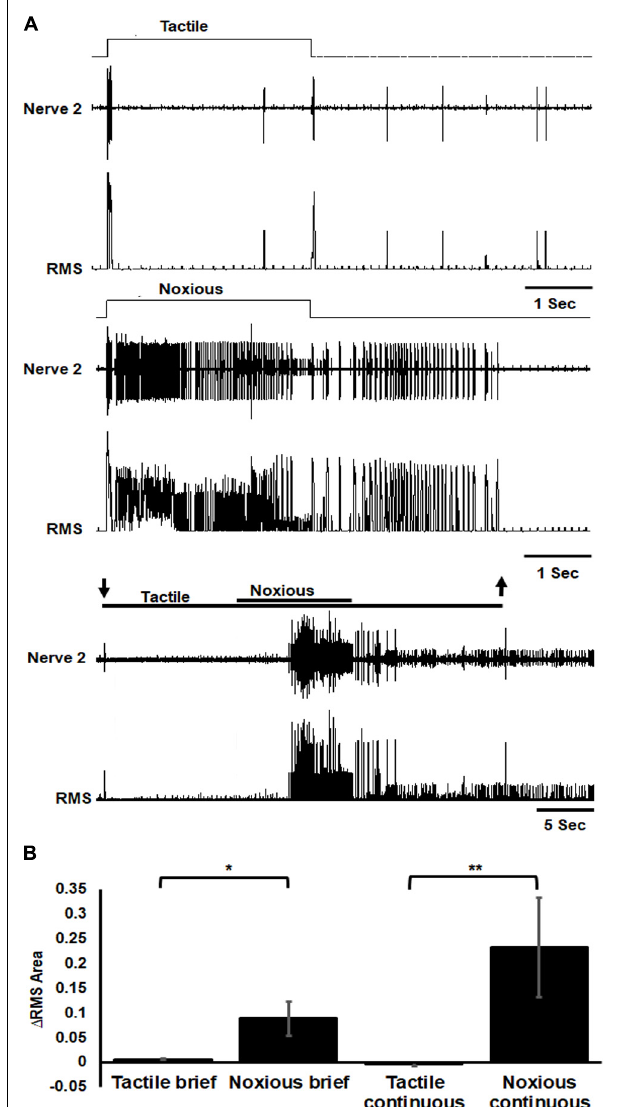
FIGURE 3 | Sensory axons response to noxious stimulus is stronger than the response to tactile stimulus. (A) Extracellular recording of abdominal nerve 2 shows that the response to brief (3 s) tactile stimulus (two upper traces) is transient in the onset and offset of the stimulus while the response to brief (3 s) noxious stimulus (two middle traces) is prolonged and involves different units from that of tactile stimulus. Continuous transition from tactile to noxious stimuli (two lower traces) shows a transient response to tactile stimulus and an ongoing response to noxious stimulus. Stimulus duration is indicated with horizontal lines and arrows (upper line: noxious; lower line: tactile). The upper trace of each stimulus example (tactile, noxious or continuous transition) is the response of the nerve and the lower trace is the same data after RMS procedure. (B) The averaged RMS area shows that the response to brief or continuous noxious stimuli is stronger than that of tactile stimuli. Bars represent means ± SEM, significance is indicated with